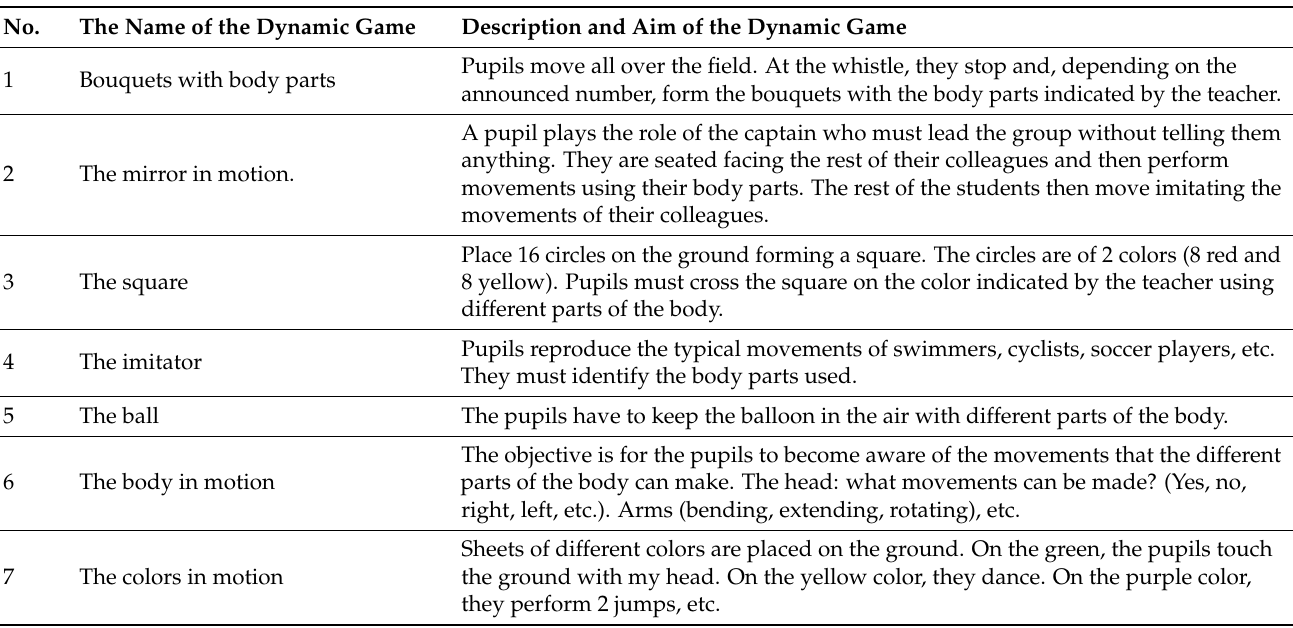
Table 1. The dynamic games used in the intervention